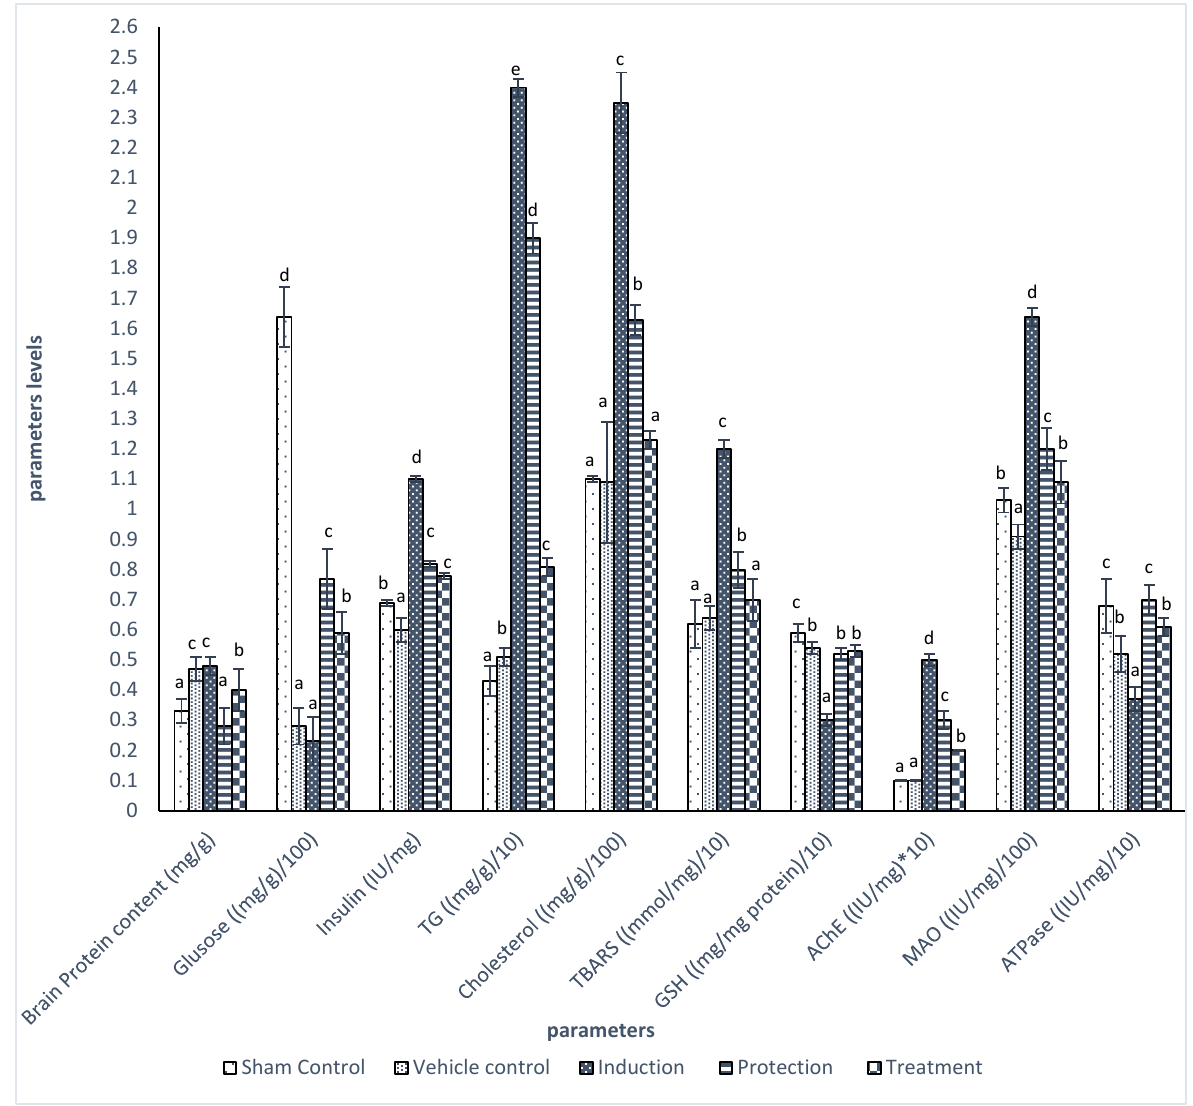
Figure 3. Effect of different treatments on brain protein, glucose, insulin, TG, cholesterol, energy- producing markers (acetaldehyde and ATPase), oxidative stress markers (TBARS and GSH), neurotransmitter-catabolizing enzymes (AChE and MAO), and fibrotic marker (hyaluronidase). Data are represented as M ± SD. For each parameter, means with different letters are significantly different at p < 0.05. The mean with the letter (a) is the smallest, followed by b, c, etc. * is multiplication sign.